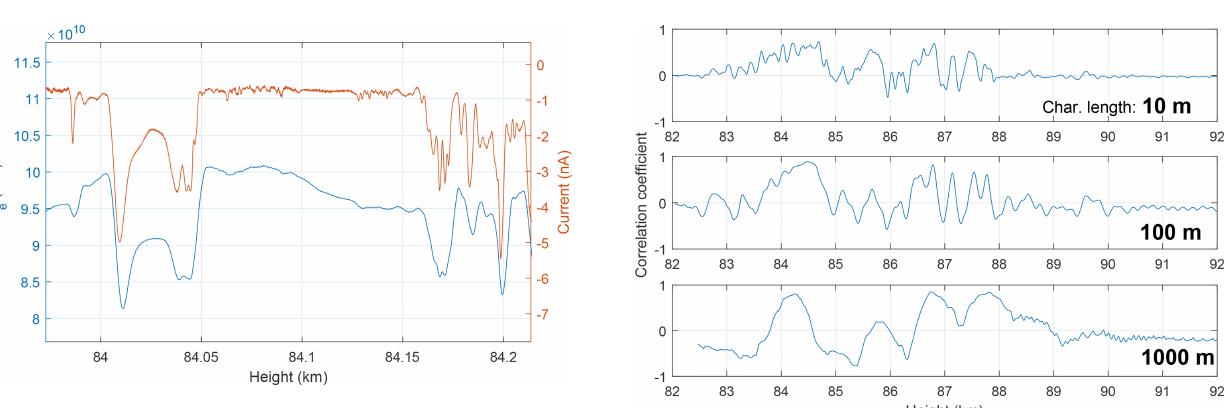
Figure 11. Close-up of structure where the electron density and DUSTY-1 currents agree well, during the MXD-1B launch. We note that the electron density height vector is shifted according to the an- gle between DUSTY-1 and mNLP boom 1 ( ∼ 20m in height). We note a correlation on length scales ∼ 10m implying anti-correlation between absolute densities.